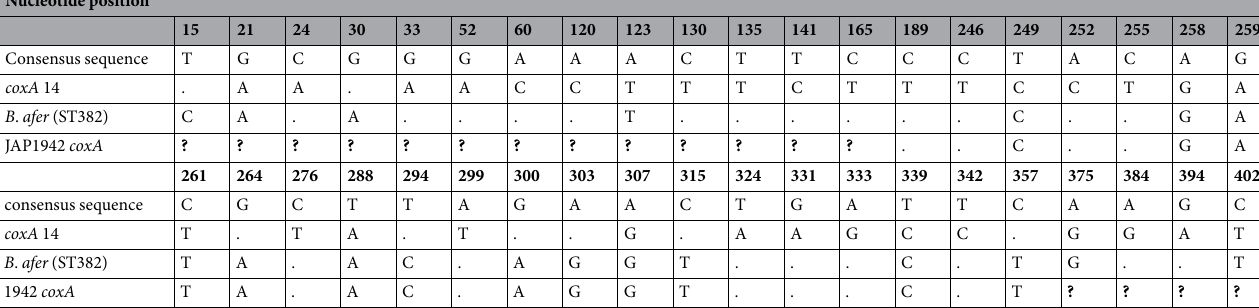
Table 4. Comparison of single nucleotide polymorphism (SNP) profile of the Wolbachia coxA gene between known Bemisia tabaci cryptic species, B . afer , and the Japanese 1942 (JAP1942) Bemisia specimen. coxA -14 sequences include B . tabaci SSA1-SG1, and B . tabaci SSA1-SG2 and are as reported in ref. 34. Consensus sequence identies are noted below. coxA missing regions for the 1942 Japanese Bemisia speciemen are between nucleotide positions 1 and 174, and from 364 to 402. Unknown SNP porfiles are indicated by ‘?’. Note : consensus sequence SNP profiles were from identical coxA_88 seqeunce. coxA sequences aligned included: HQ404793, JQ013511, B . tabaci Q(ST116), B . tabaci Asia-I (ST378, ST385, ST395), B . tabaci Asia II-1 (ST389, ST390, ST391, ST392), B . tabaci Asia II-3 (ST396), B . tabaci Asia Ii-6 (ST393, ST394), B . tabaci Asia